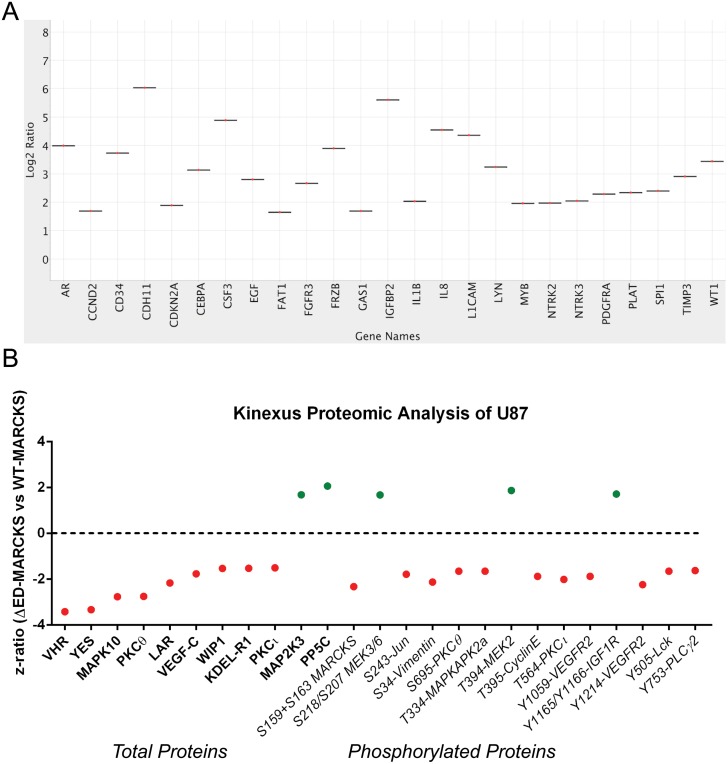
Changes in RNA expression and protein levels with ED-deleted MARCKS.
A) After overnight doxycycline-induction of ΔED-MARCKS or WT-MARCKS U87 cells, RNA was collected and ran on NanoString nCounter GX Human Cancer Reference Kit. Data was analyzed on nSolver software. Violin plot displays > 1.5 log fold increase in GBM cells overexpressing an ΔED-MARCKS protein as compared to WT MARCKS. B) Changes in total protein levels as well as phosphorylated protein levels between the ΔED and WT- MARCKS expressing U87 GBM cell lines were determined by Kinex KAM-850 microarray. Data is displayed as z-ratio of ΔED results compared to WT-MARCKS results. Increase in z-ratio is indicated in green dots while decrease is indicated in red dots. Total protein targets are listed in standard font while phosphorylated proteins are listed in italicized font with phosphorylated amino acids designated.